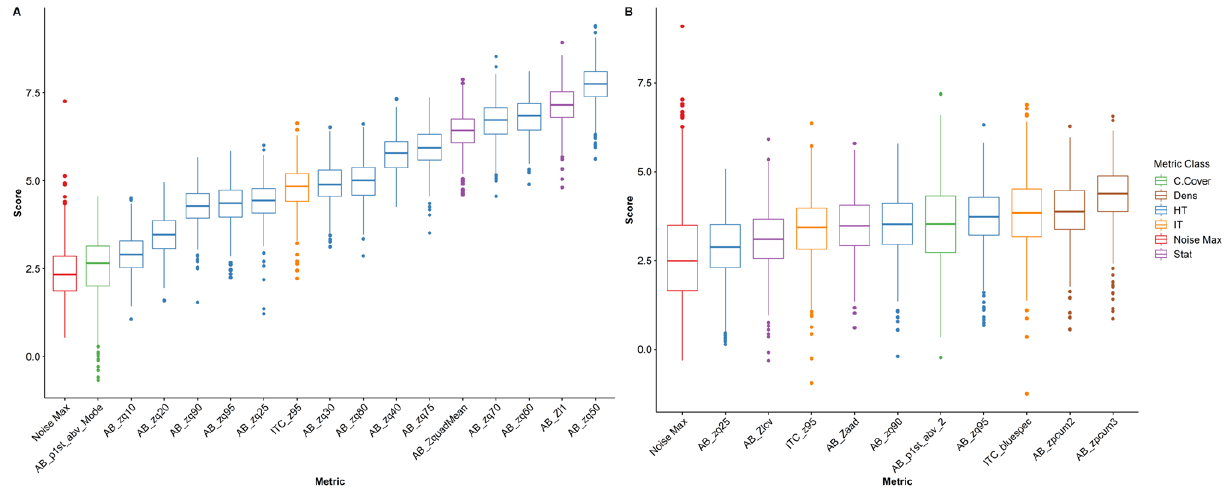
Figure 3. Boruta variable selection results showing the distribution of variable importance scores of selected metrics for the merchantable volume component ( A ) and non-merchantable volume component ( B ). Color indicates metric classes of canopy cover (C. Cover) (green), density (Dens) (brown), height (HT) (blue), individual tree (IT) (orange), statistical (Stat) (purple), and the highest- scoring noise variable (Noise Max) (red).